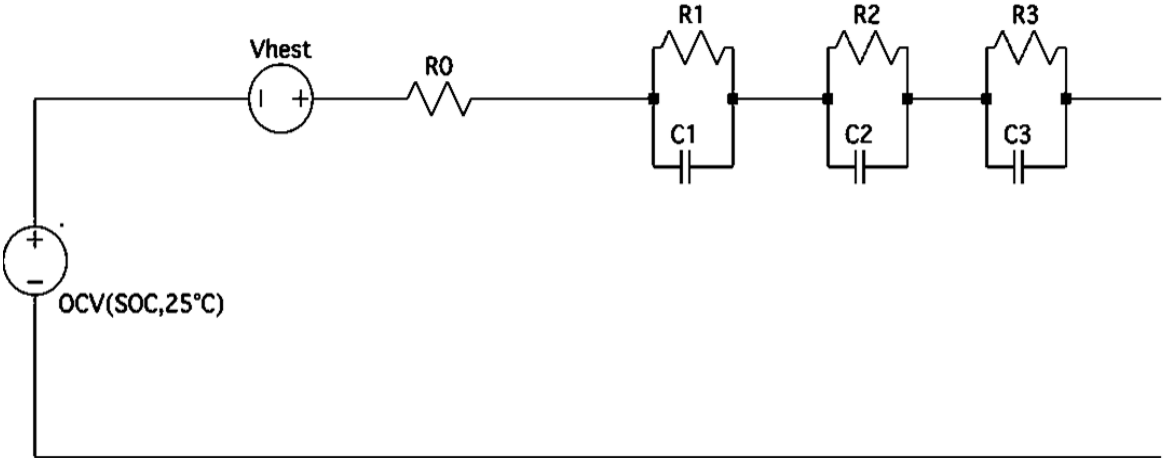
Figure 2. EECM of the Li-ion cell.